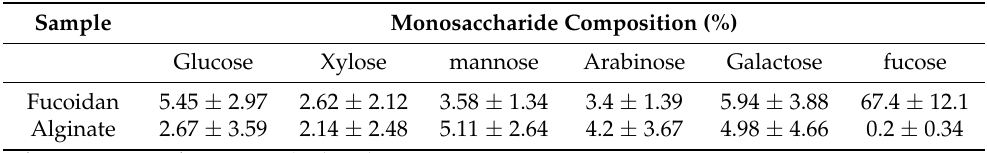
Table 2. Monosaccharides composition of fucoidan and alginate of C. sinuosa determined by HPLC- RI analysis.